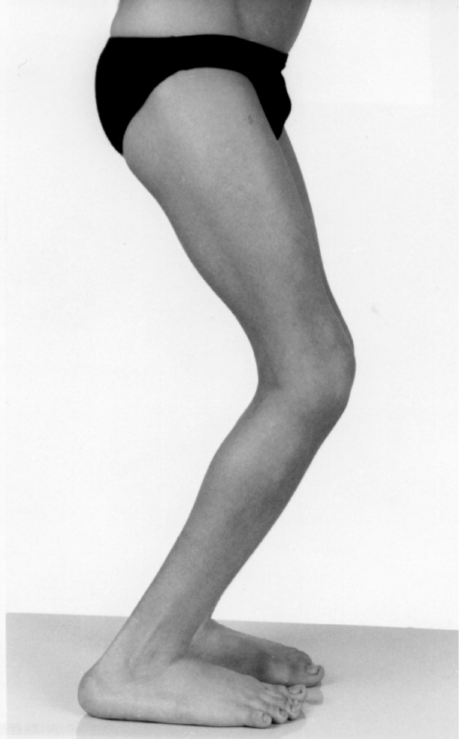
Figure 2. A 10-year old boy with spastic diplegia, GMFCS III with iatrogenic crouch gait after